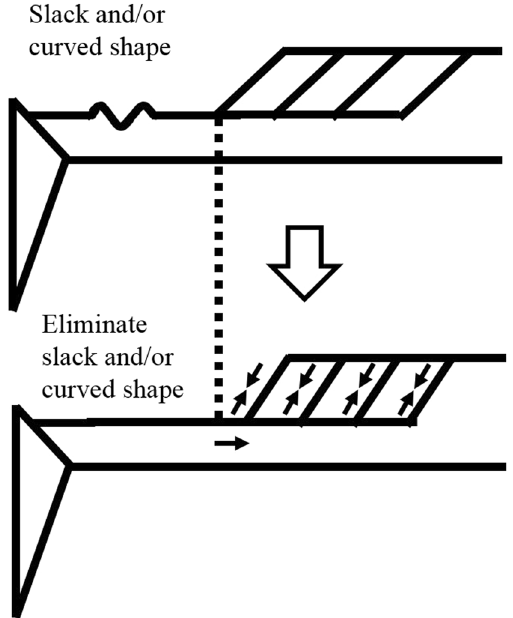
Figure 3. Schematic representation of the interaction between slack and/or curved shape and muscle fascicle shortening at a given ankle joint